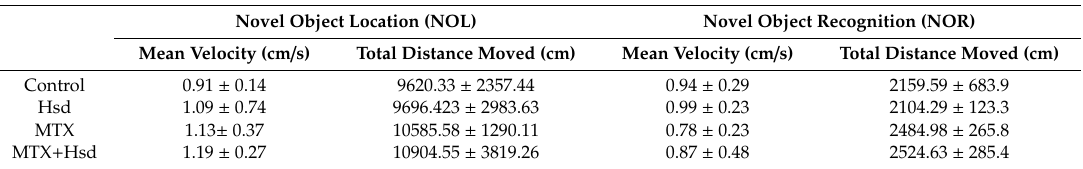
Table 1. Mean velocity and total distance moved of the animals in the novel object location (NOL) and novel object recognition (NOR) tests after treatment.